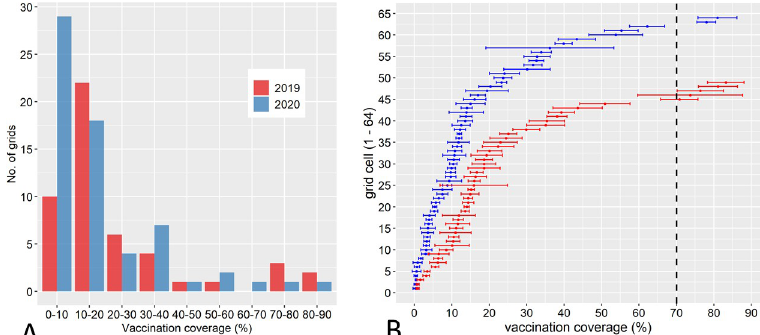
Fig 3. Bar graph and plots of vaccination coverage by grid cells. Correlation between number of grid cells and dog vaccination achieved during the 2019 and 2020 MDV campaign in the four regions of NCA, Namibia ( A ). A plot of dog vaccination coverage (%) per grid cells with 95% confidence intervals presented as horizontal bars for 2019 (red) and 2020 (blue) vaccination campaign is shown in ( B ). The vertical dashed line represents the 70% recommended